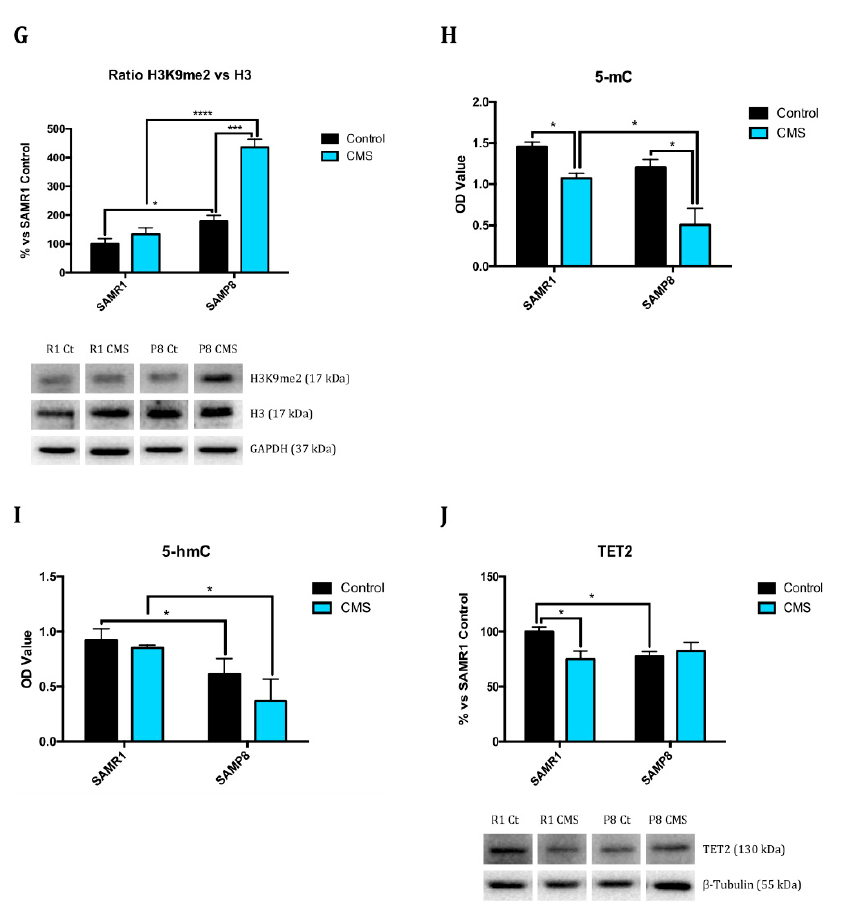
Figure 1. Epigenetic marker changes after CMS. Representative Western Blot for the ratio of Acetylated at Lys9 H3 protein levels and quantification ( A ), the ratio of Acetylated at Lys 12 H4 protein levels and quantification( B ), HDAC2 protein levels and quantification ( C ), the ratio of p-H2A.X protein levels and quantification ( F ), the ratio of H3K9me2 protein levels and quantification ( G ), and TET2 protein levels and quantification ( J ). Relative gene expression of Sirt1 ( D ) and Sirt6 ( E ). Global 5-methylated cytosine ( H ) and 5-hydroxymethylated cytosine levels ( I ). Gene expression levels were determined by real-time PCR. Values in bar graphs are adjusted to 100% for protein levels of SAMR1 control (R1 Ct). Values are mean ± Standard error of the mean (SEM); ( n = 4 for each group). * p < 0.05; ** p < 0.01; *** p < 0.001; **** p < 0.0001.